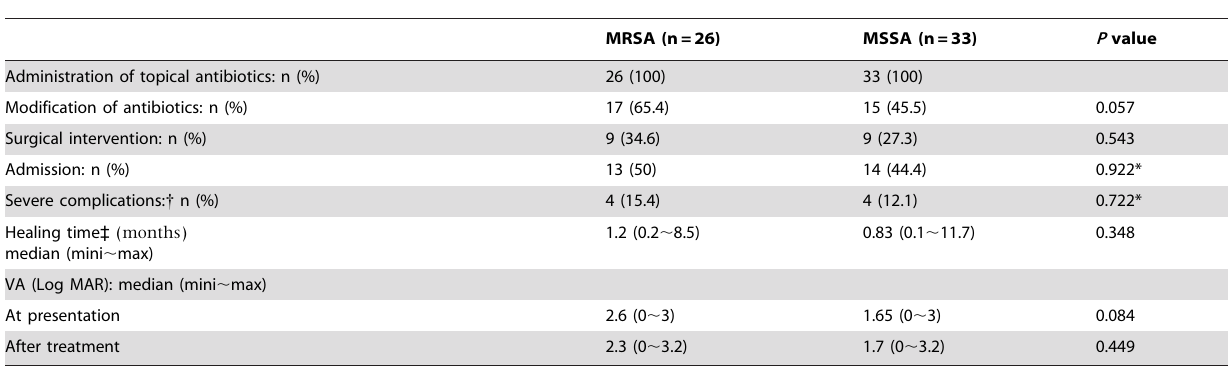
Table 5. Treatment and clinical outcome of MRSA and MSSA